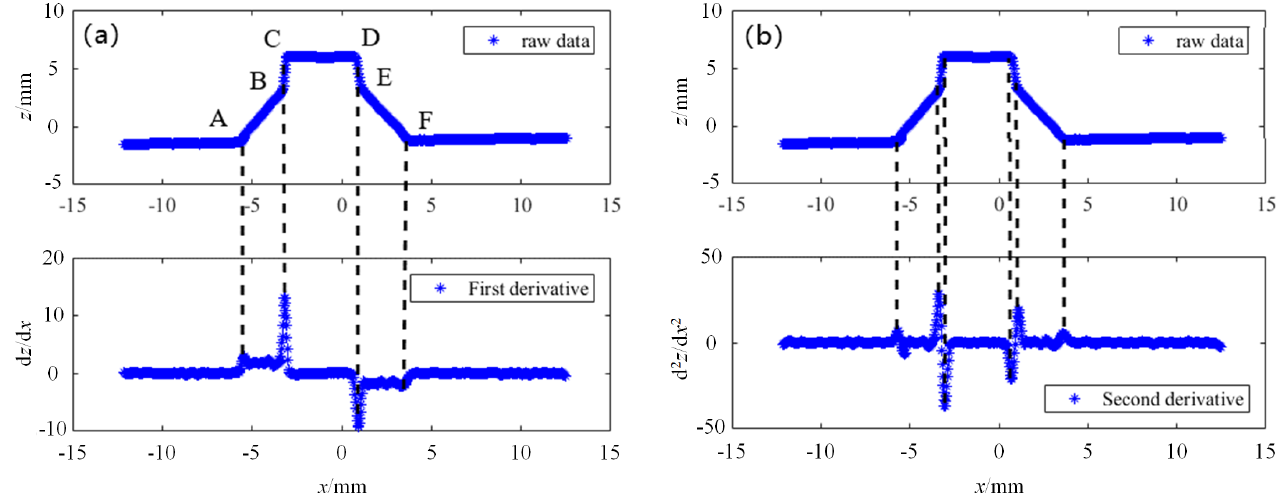
Figure 4. Initial positioning of feature points for ( a ) the first type of feature points; and ( b ) all feature points.